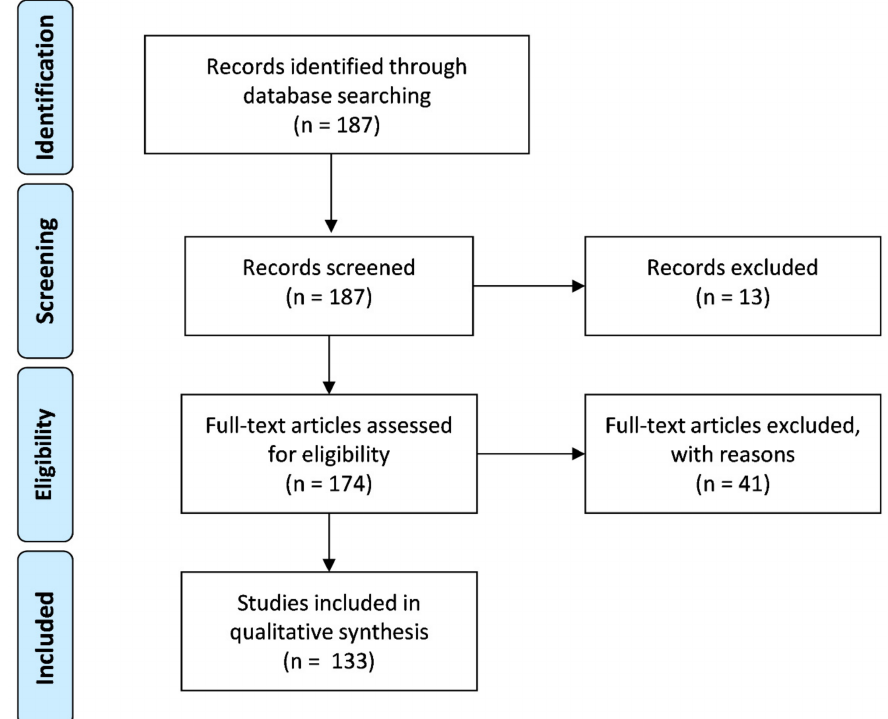
Figure 1. PRISMA flow diagram of eligible studies for this systematic review. Two hundred and fifty- seven studies were identified and screened. Twenty-eight studies were excluded after screening the title and abstract. Fifty-three additional studies were excluded on the basis of violation of inclusion criteria. A total of 176 full text articles were included in this study. The identity of all 257 articles and the 176 included studies can be found in Table